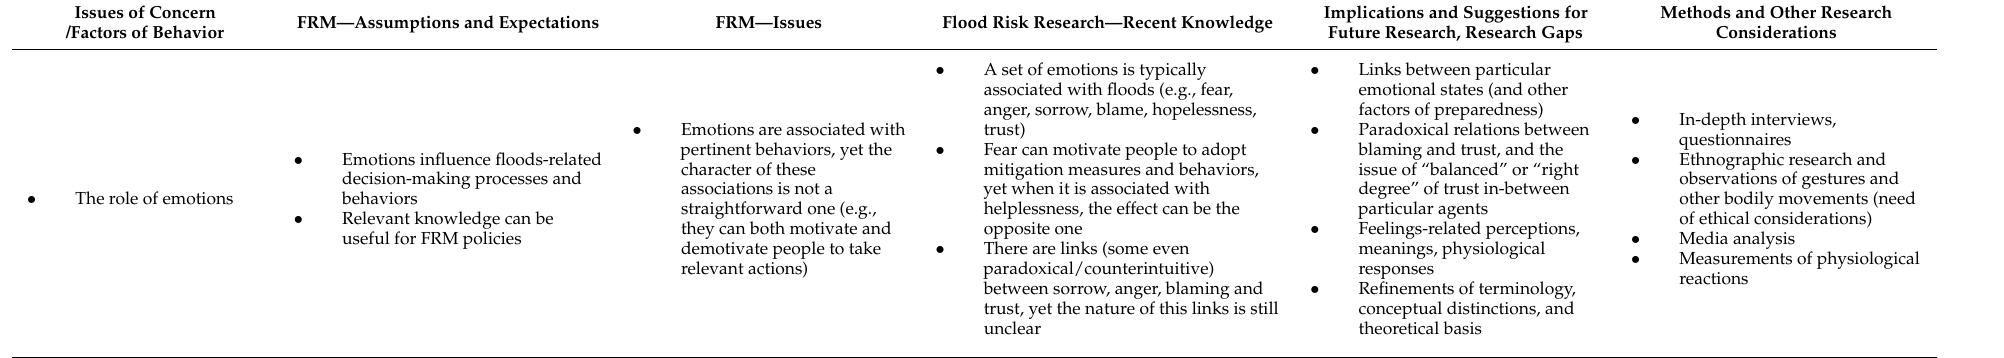
Table 7. Emotions/feelings–overview of findings, implications, and suggestions for future flood risk research agenda.